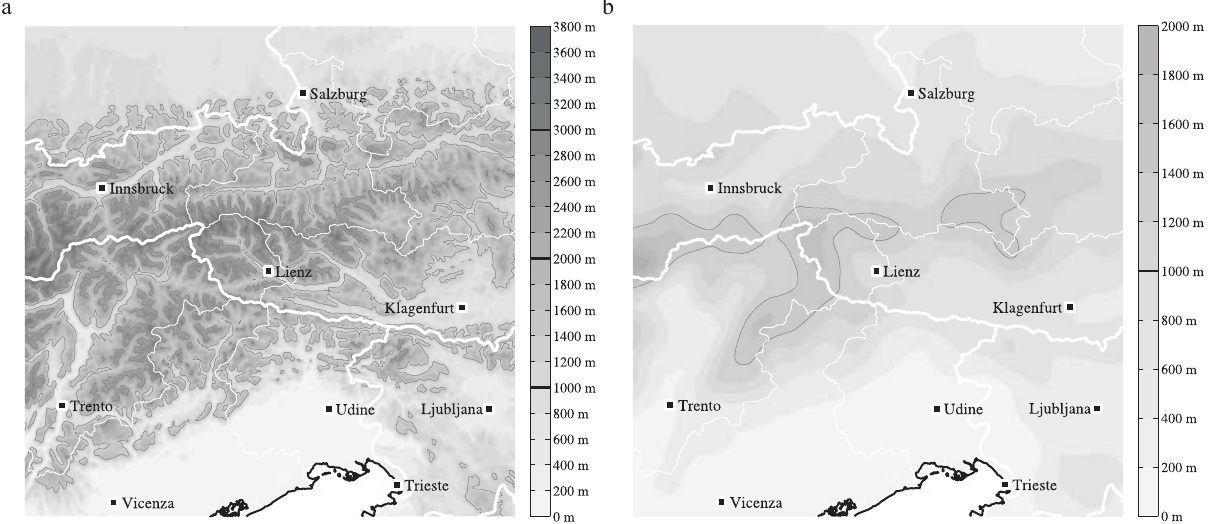
Fig. 1. Comparison of the real topography (a) and the idealized minimum topography (b) for the Central Alpine domain. The bold white lines illustrate national borders and thin white lines federal state borders. The black solid line in the south shows the coastline of the most northern part of the Mediterranean Sea. Major cities are marked by black squares with white frames. The shading refers to the absolute height above sea level.